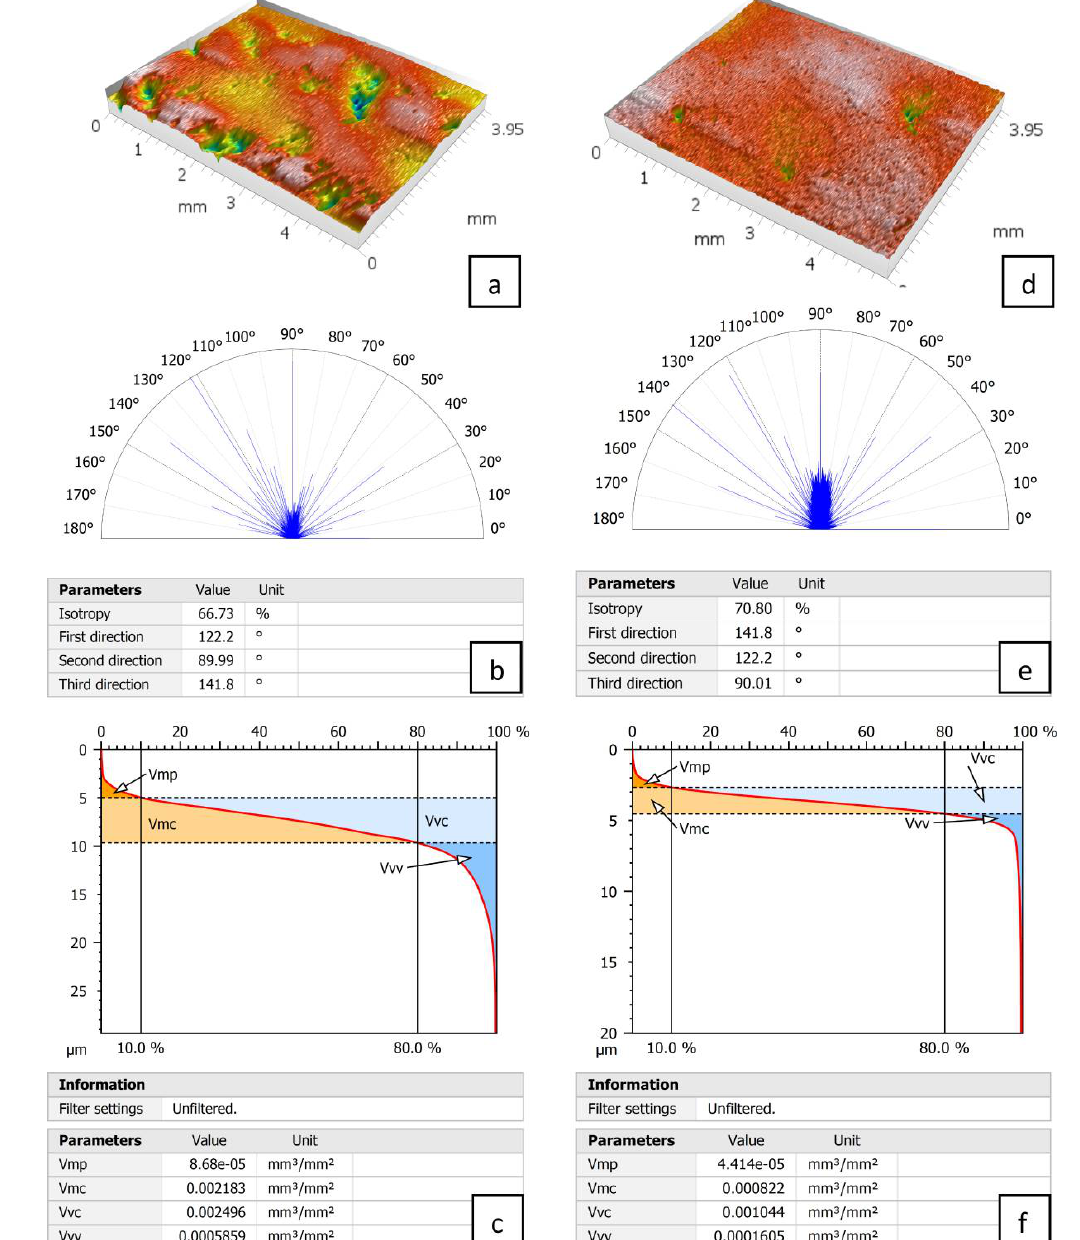
Figure 8. Analysis of the 0° slope surface after 12 h working time: false color map ( a ), isotropy analysis ( b ), and functional analysis ( c ). Analysis of the same slope after 24 h: false color map ( d ), isotropy analysis ( e ), and functional analysis ( f ).